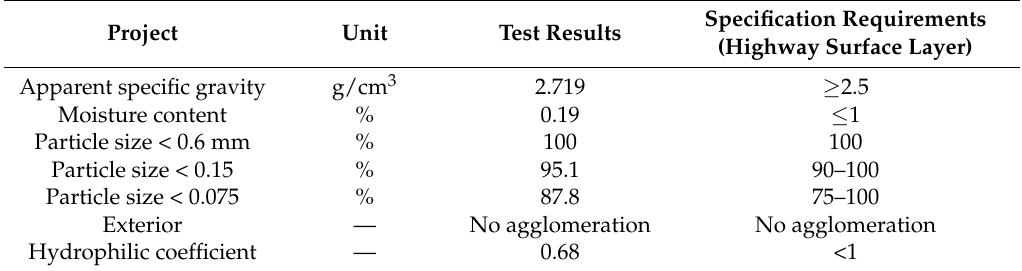
Table 4. Physical properties of mineral powder.